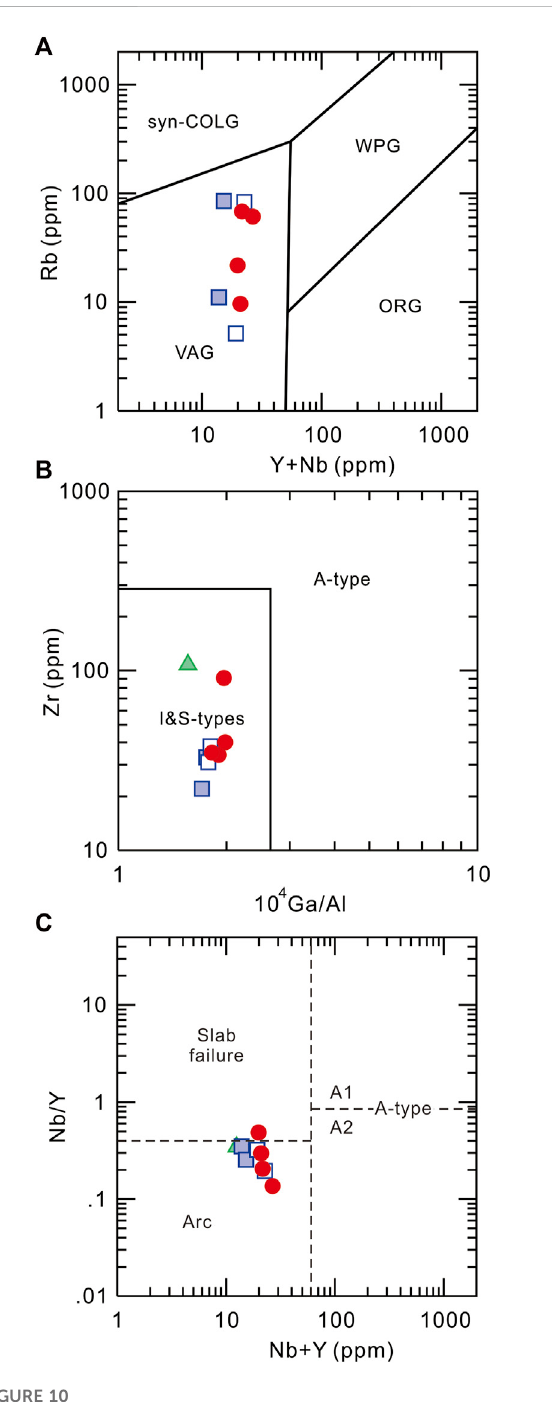
FIGURE 10 Tectonomagmatic discrimination of the dioritic and quartz dioritic rocks of the Snoul pluton of (A) Pearce et al. (1984), (B) Whalen et al. (1987), and (C) Whalen and Hildebrand (2019). Symbols of the Snoul pluton are the same as in Figure